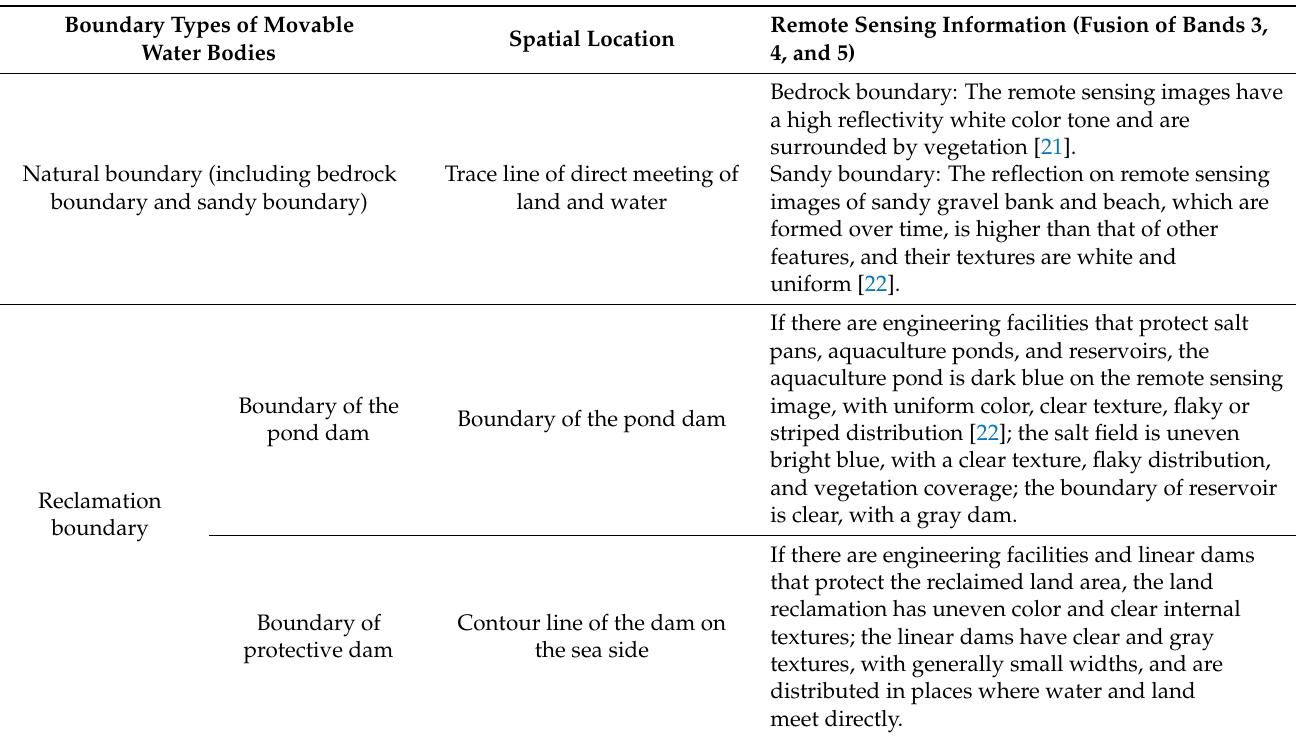
Table 2. Boundary defining methods of MWBB with different utilization types.